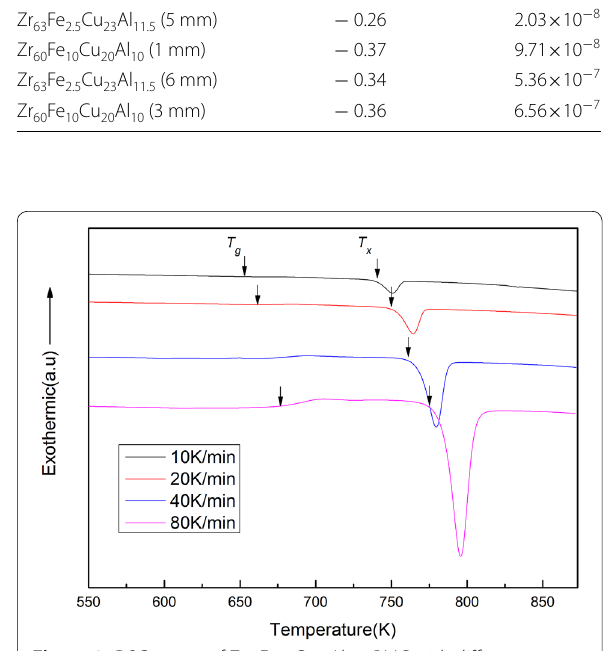
Figure 3 DSC curves of Zr 63 Fe 2.5 Cu 23 Al 11.5 BMG with different heating